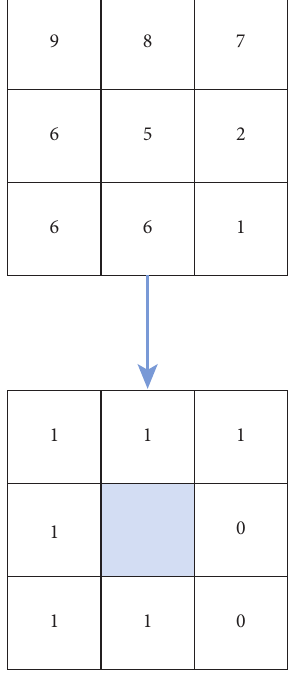
Figure 4: Local binarization process.